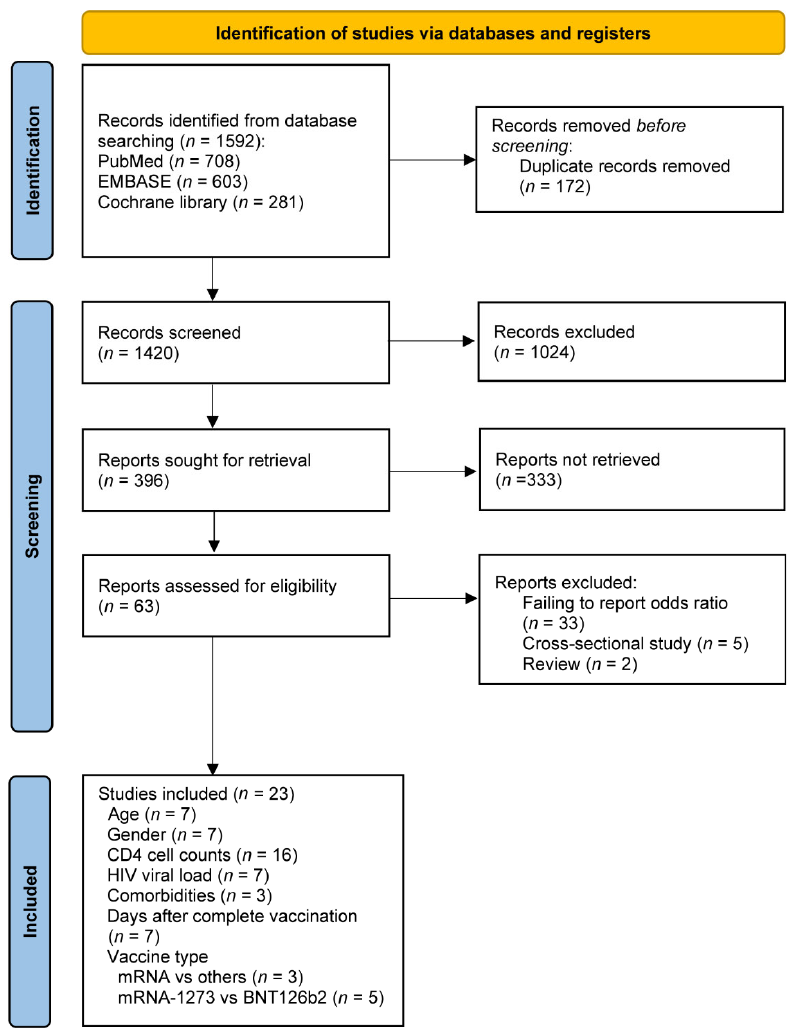
Figure 1. Flowcharts illustrating the article selection process.